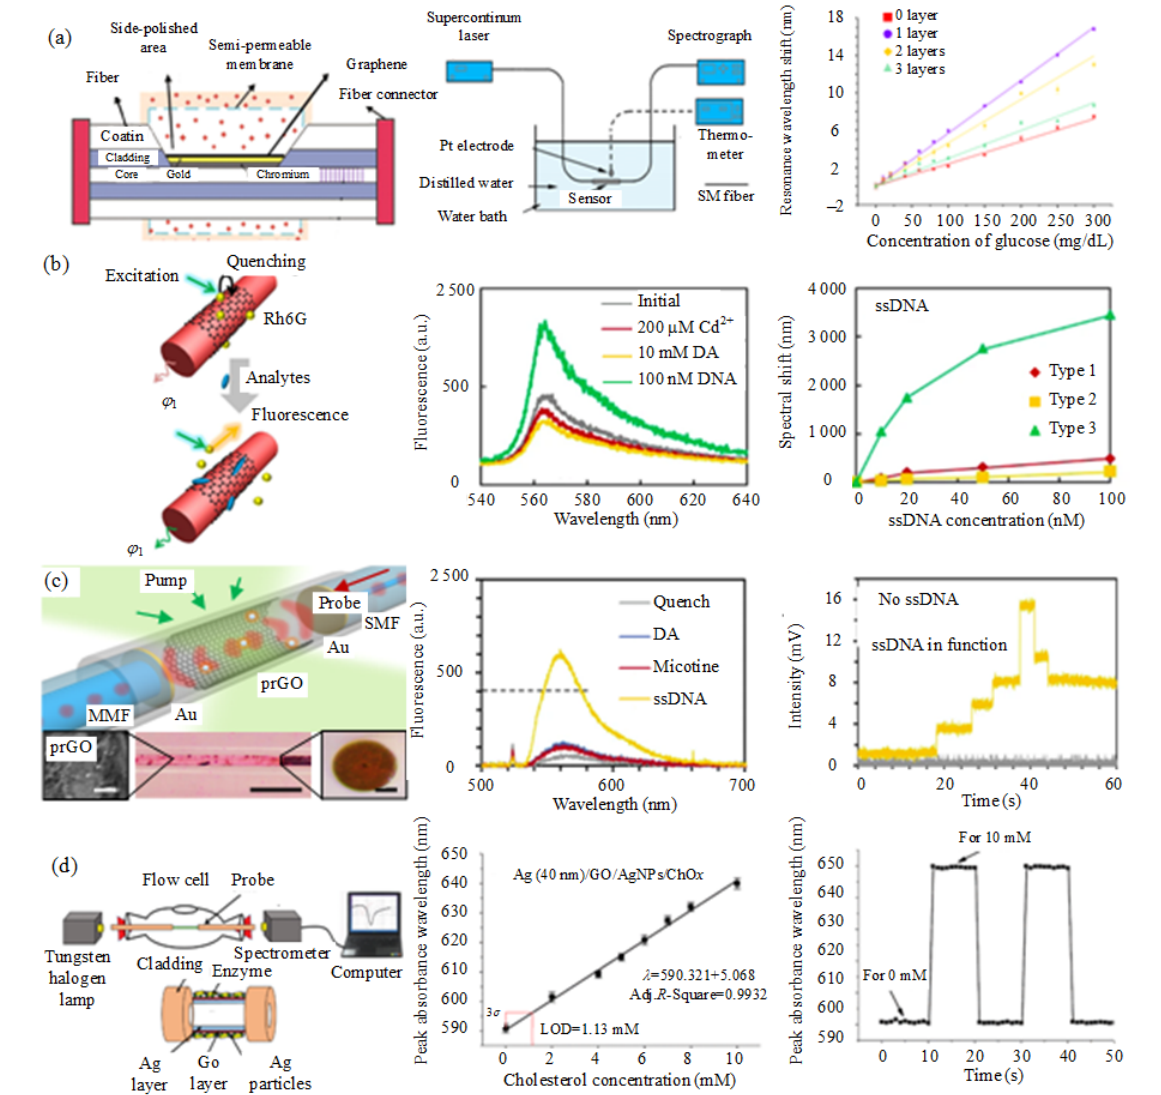
Fig. 5 Graphene-fiber biosensors: (a) gold-graphene/D-shaped fiber sensor for glucose [69], (b) prGO/microfiber sensor with selectivity [35], (c) prGO/microcavity sensor with individual molecule selectivity and sensitivity [5], and (d) silver nanoparticles coated GO/unclad fiber for Cholesterol sensor